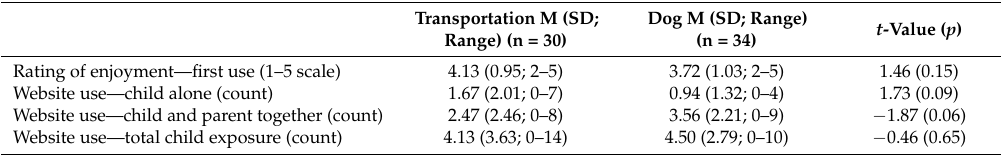
Table 2. Website use and enjoyment across groups, and independent samples t -test results.